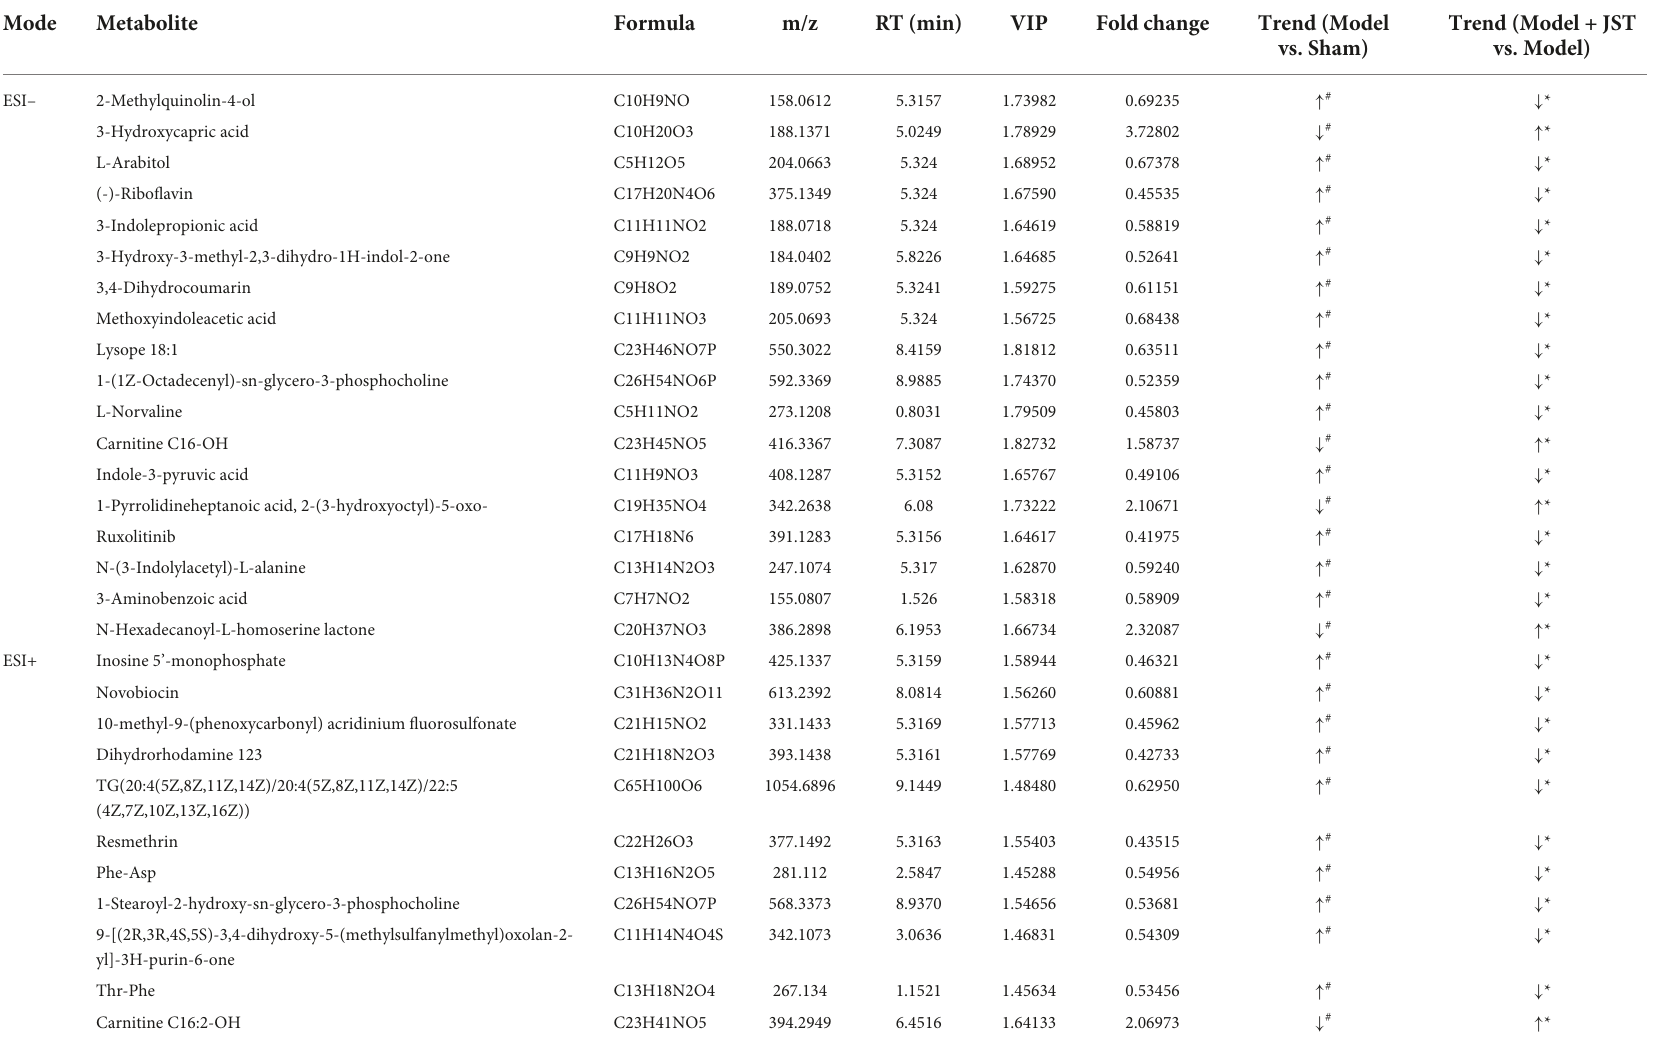
TABLE 1 Identified potential biomarkers regulated by